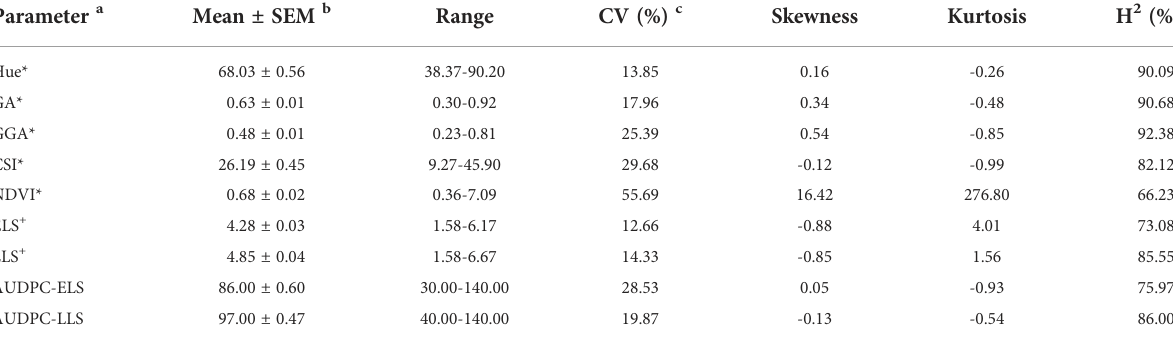
TABLE 1 Descriptive statistics and broad-sense heritability of nine traits. Parameter a